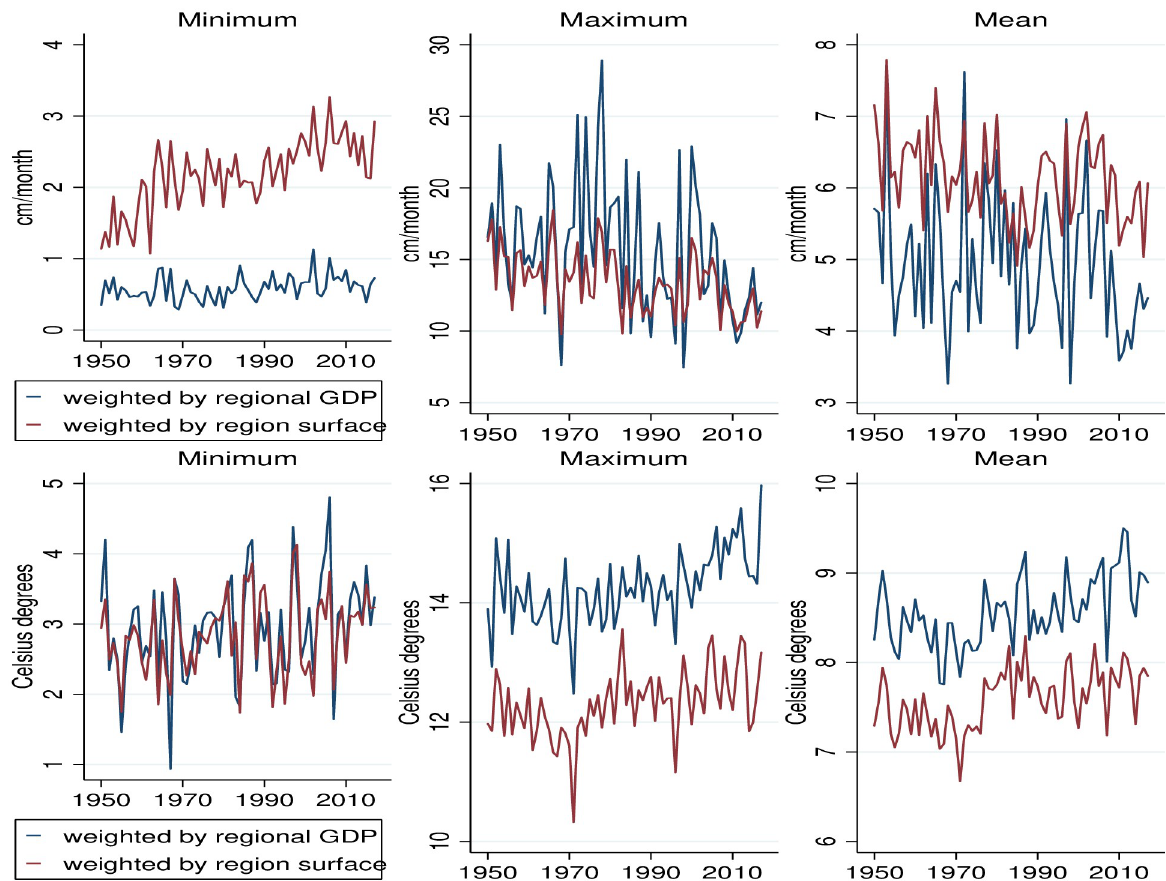
Fig 1. The evolution of the yearly precipitation and temperature (weighted by the regional GDP in 2017 or by the surface area of each region) during the period 1950–2017. Minimum, Maximum and Mean values are from January to December of each year.